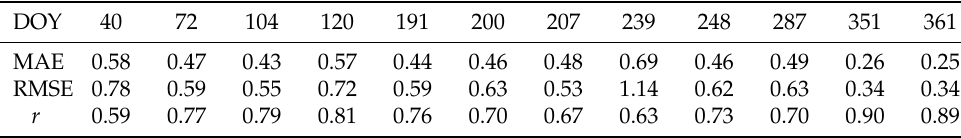
Figure 13. Bar graph of LAI predictions statistics (MAE, RMSE, and r ) at the CCN area. Table 10. Quantitative validation of LAI for all input days at the CCN area.